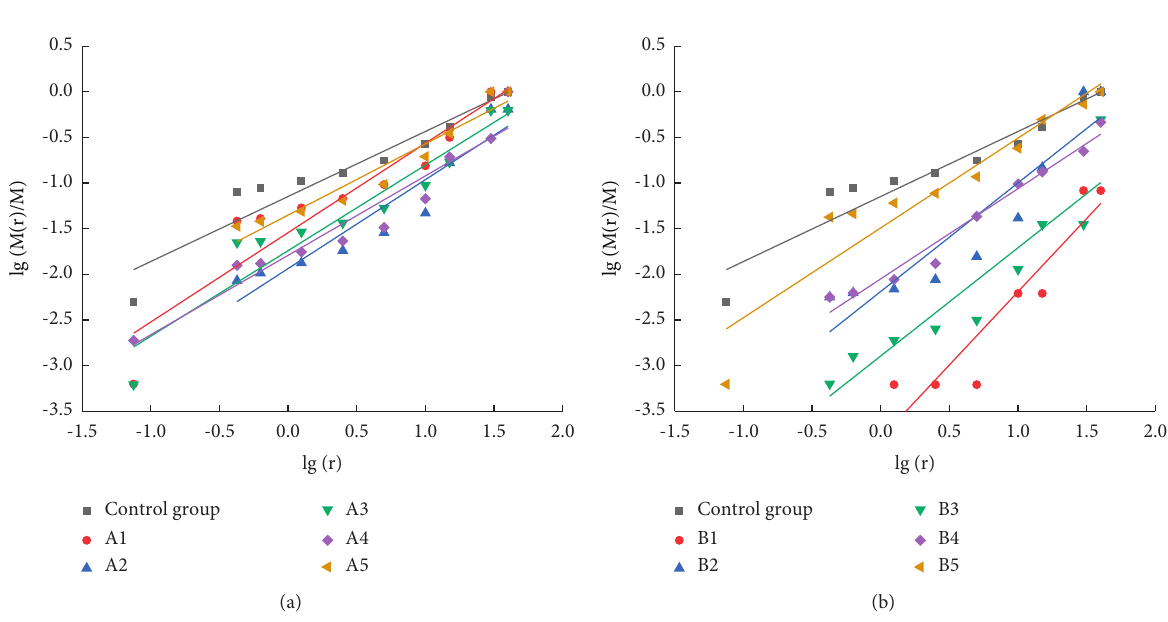
Figure 9: The fitting relationship between lg( M ( r )/ M ) and lg( r ). (a) Perpendicular to the slit direction. (b) Parallel to the slit